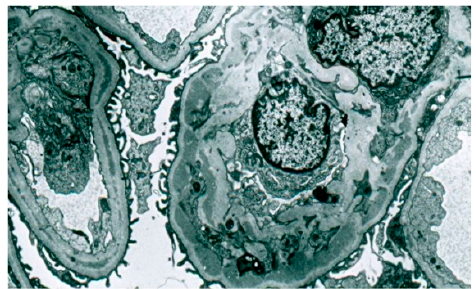
Figure 6. A case of C3GN. Electron microscopic image of the glomerulus, with transposition of mesangial cell protuberances to the periphery of capillary loops and with a ‘double’ basement membrane. Subendothelial deposits. Electron microscopy, 8750× magni fi cation.